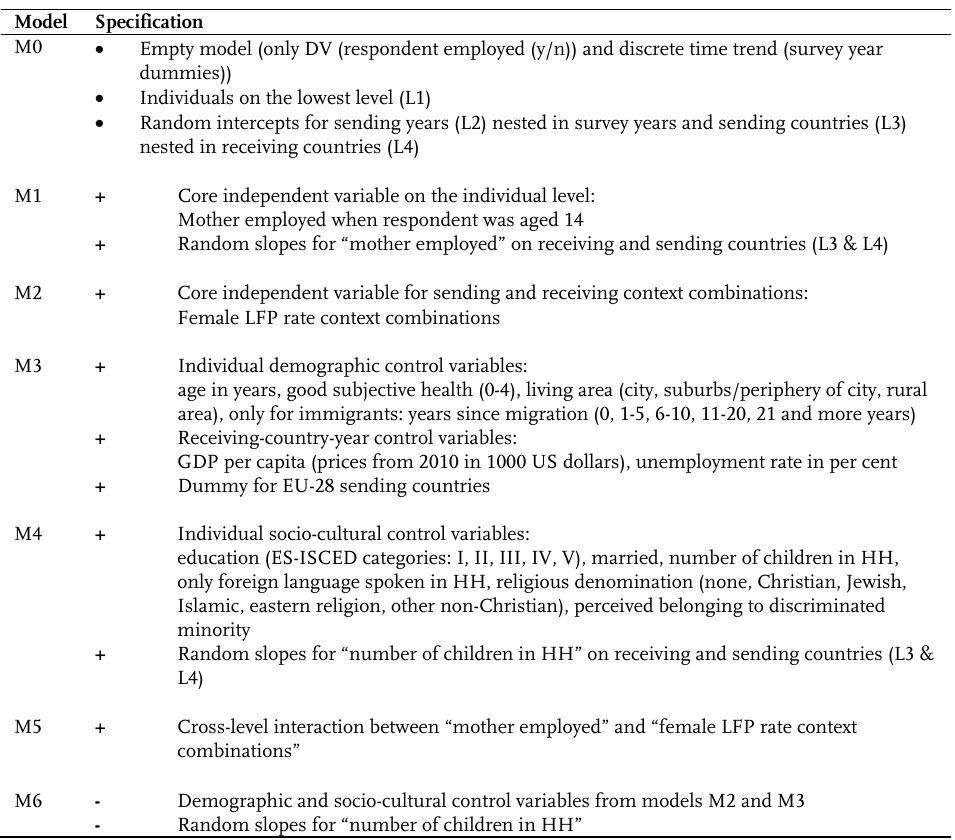
Table 1 : Specifications of multilevel linear probability models